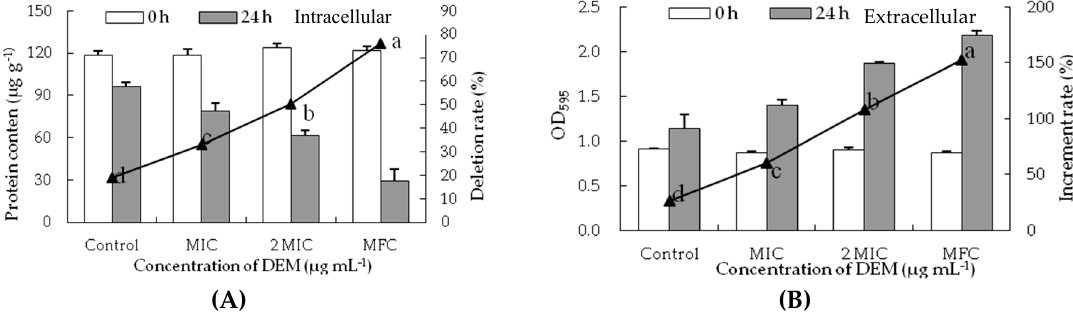
Figure 5. Effect of DEM on protein content from intracellular ( A ) and extracellular ( B ) of P. italicum .